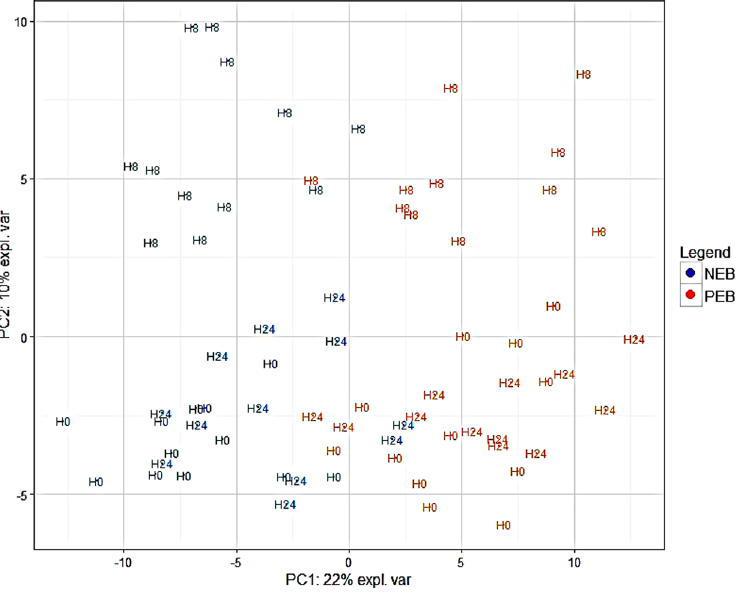
Figure 1. PCA performed on the 191 DEGs in response to energy restriction. The orange and blue colors indicate samples from Positive Energy Balance (PEB) and Negative Energy Balance (NEB), respectively. H0, H8 and H24 indicate the sampling hour relative to the inflammatory challenge.